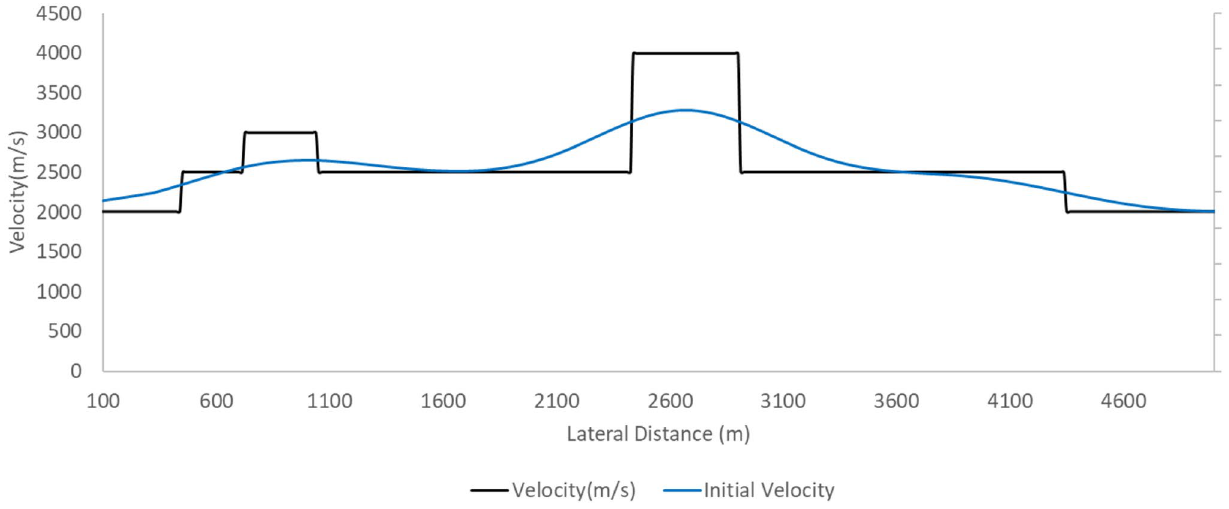
Fig. 11 Actual and Initial Velocity